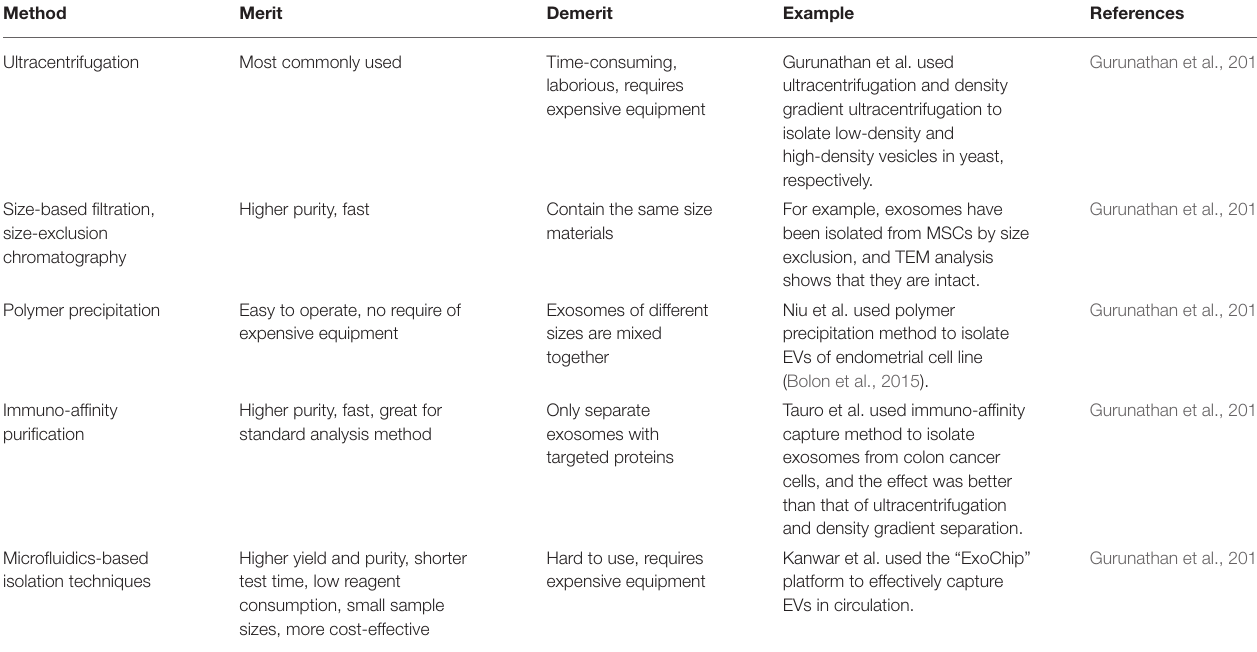
TABLE 2 | Methods of exosome